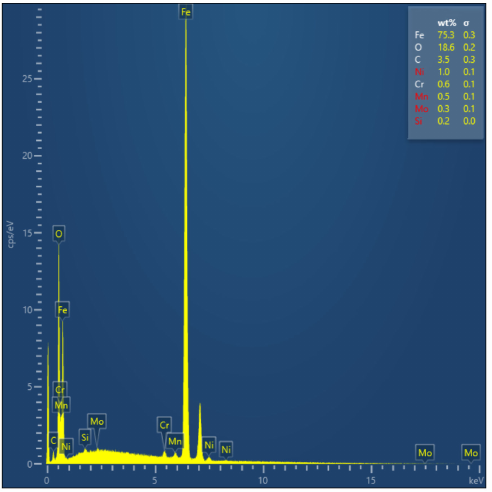
Figure 28. The EDS analysis results of area A in Figure